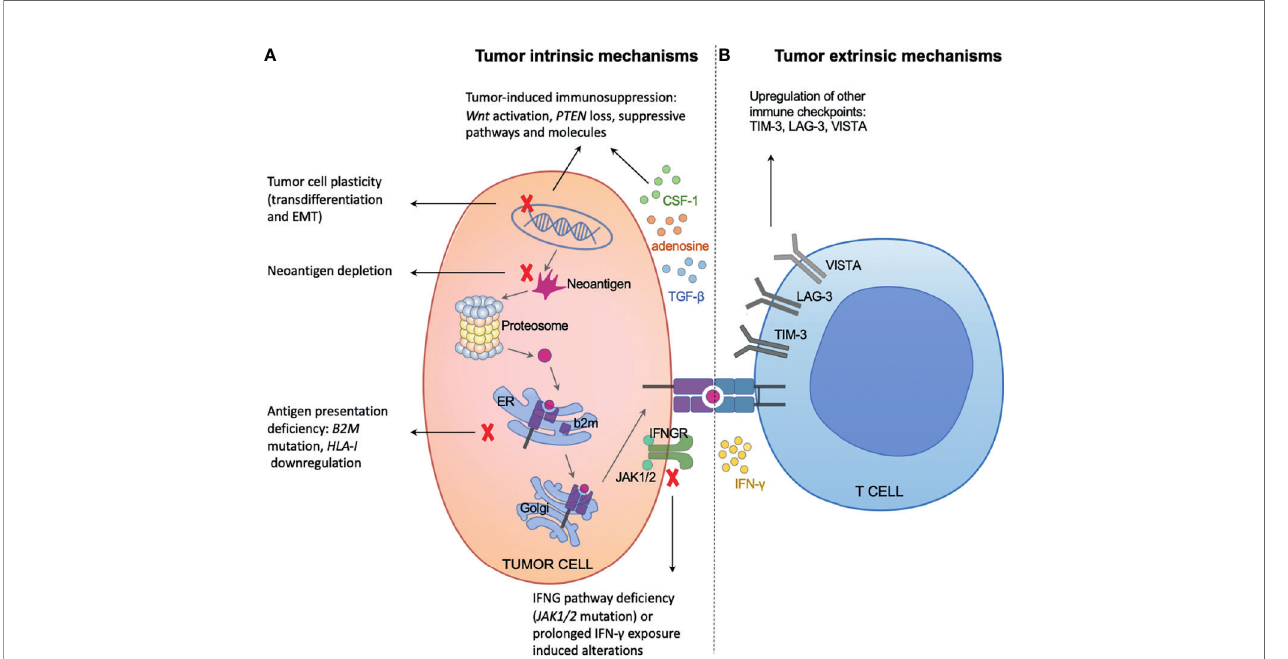
FIGURE 2 | Tumor intrinsic and extrinsic mechanisms of acquired resistance to immunotherapy. (A) The left panel illustrates tumor intrinsic mechanisms of acquired resistance, including neoantigen depletion, defects in antigen presentation machinery, interferon signaling de fi ciency or prolonged exposure, tumor-induced exclusion/ immunosuppression, and tumor cell plasticity. (B) The right panel illustrates tumor extrinsic mechanisms of acquired resistance, mainly through upregulating other immune checkpoints, such as TIM-3, LAG-3, and